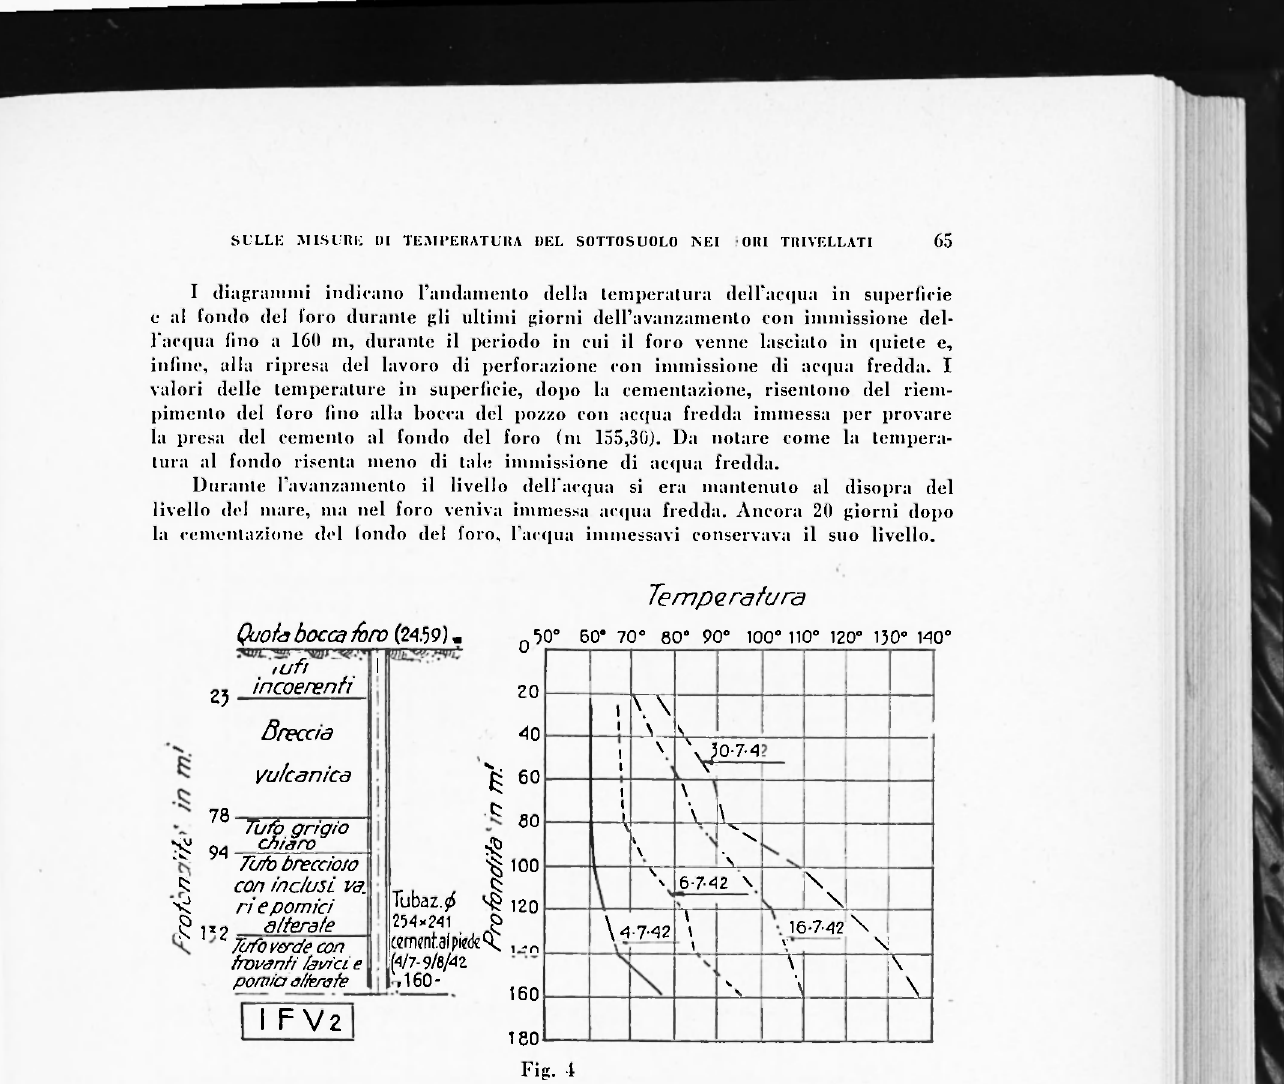
Fig. 5 - Foro IFV2. Variazioni